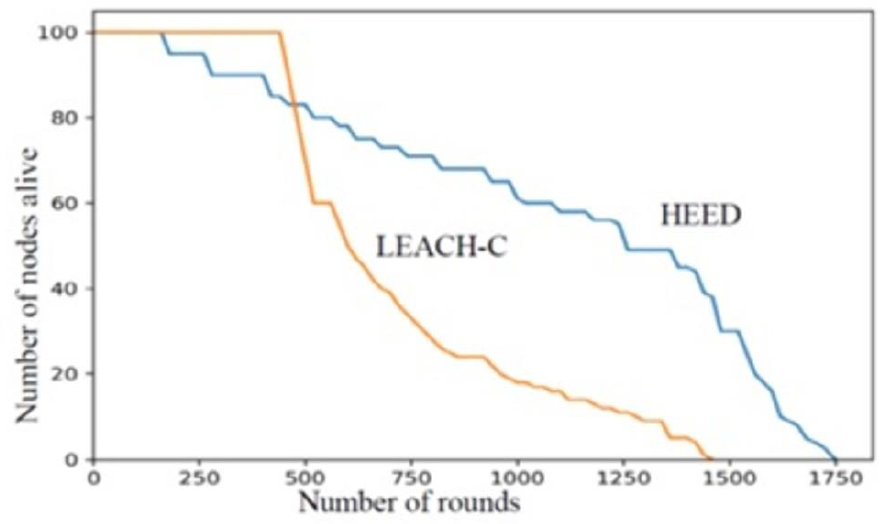
Figure 8. Number of rounds vs. number of nodes alive using the LEACH-C and HEED algorithms .